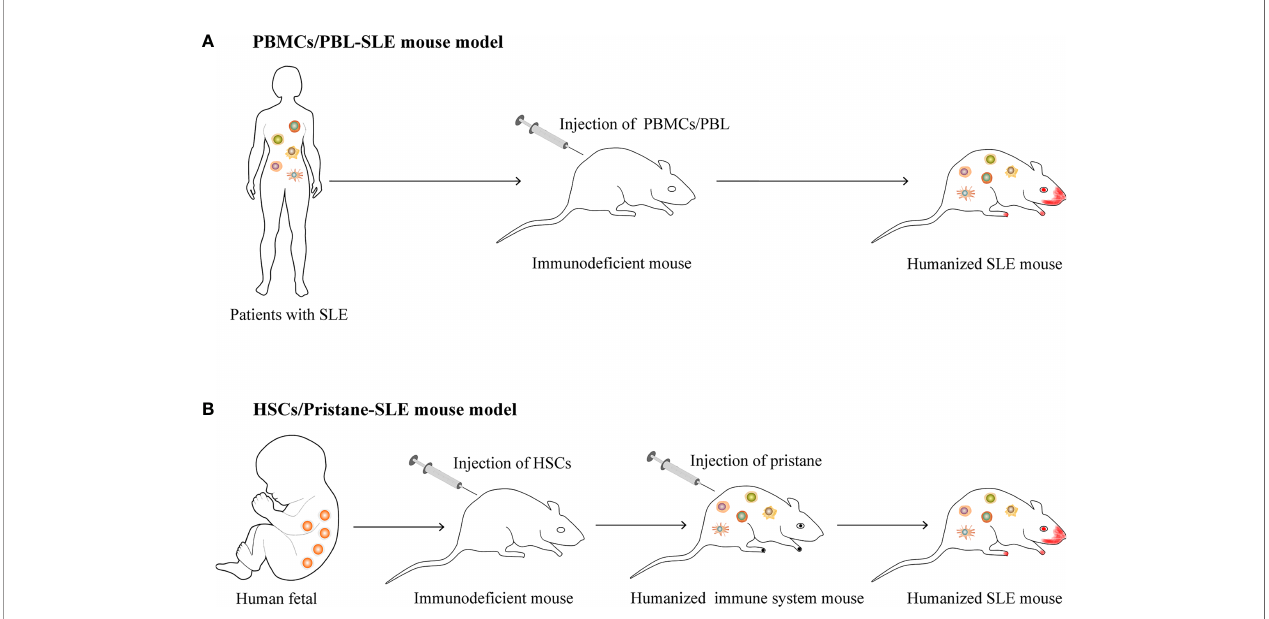
FIGURE 1 | The construction of humanized SLE mouse model. (A) Transferring human peripheral blood mononuclear cells (PBMCs) or peripheral blood lymphocytes (PBLs) from patients with SLE to immunode fi cient mice. (B) Transferring human hematopoietic stem cells (HSCs) to immunode fi cient mice and then injecting intraperitoneally ( i. p. ) with pristane to induce